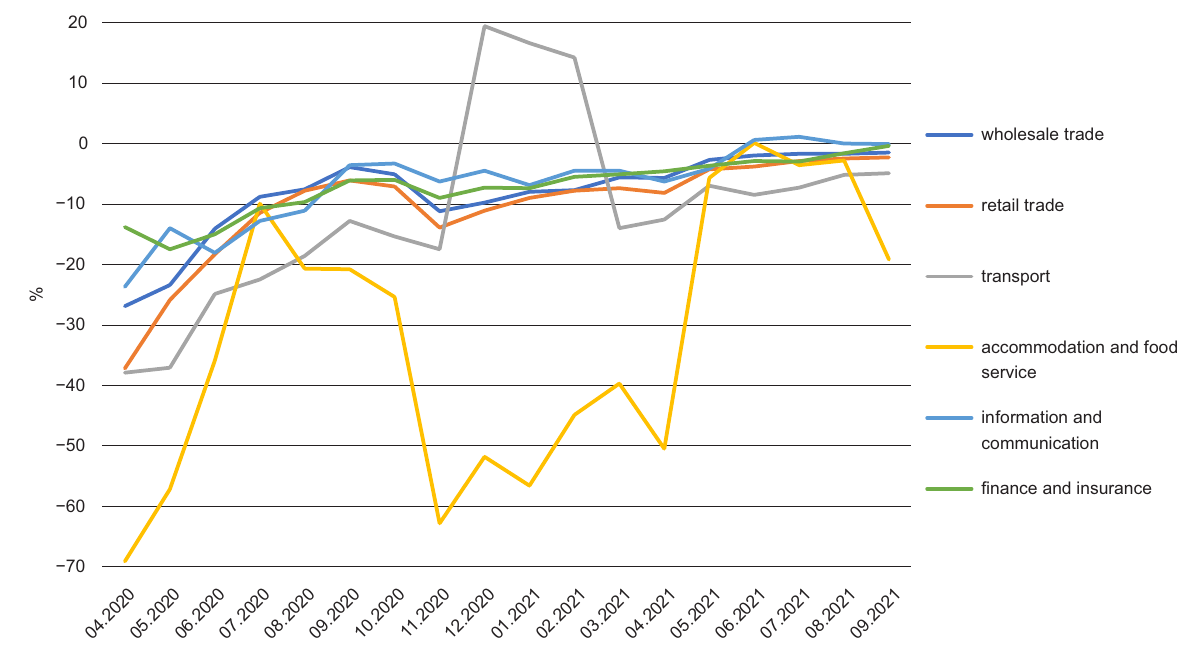
Fig. 5. Change in service orders in Poland between April 2020 and September 2021 2 .